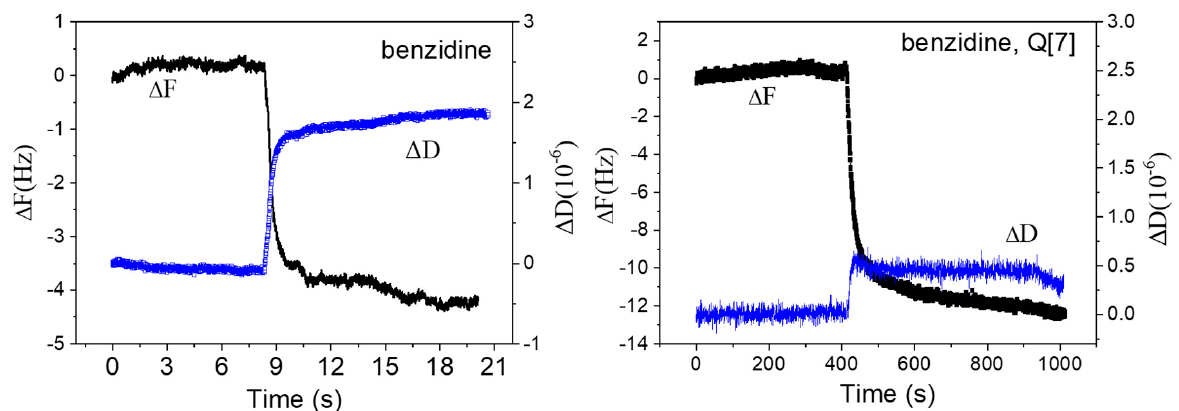
Figure 11. The variations in Δ F and Δ D with time upon addition of AN. (AN: 0.1 mmol·L − 1 ; Q[7]: 0.1 mmol·L − 1 ).